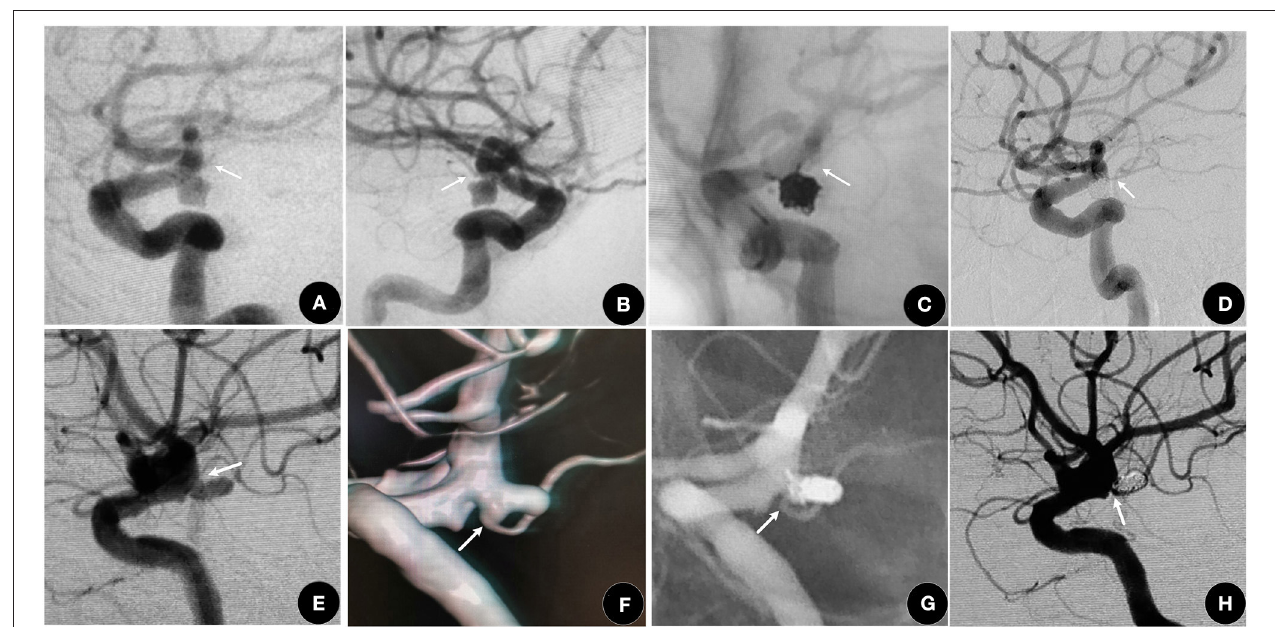
FIGURE 2 | (A–D) A 63-year-old female who suffered with an SAH for 2 days. (A,B) showing a I type aneurysm. (C) RROC 1 was achieved using the double microcatheter technique and the AChoA (arrow) was well-protected. (D) One year later, the aneurysm was still at RROC 1 with a normal AChoA (arrow). (E–H)